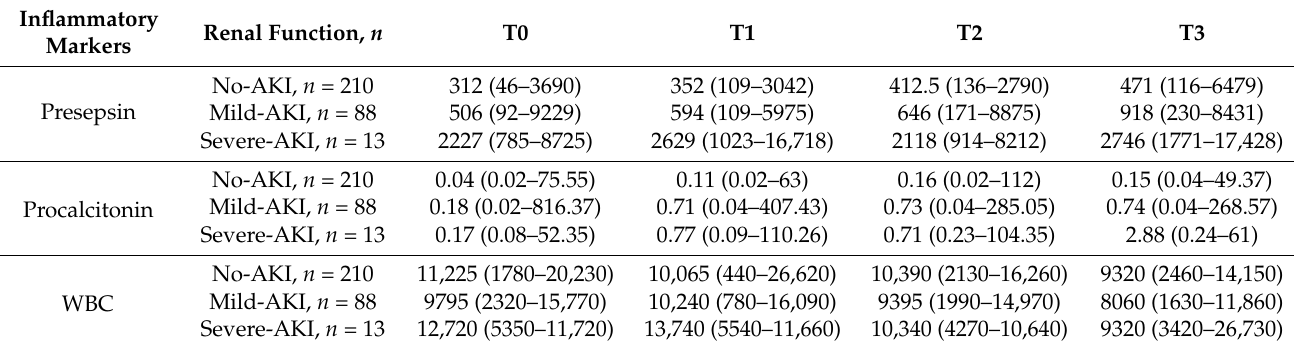
Table 5. Median values of inflammatory markers during observational period after surgery according to AKI severity: Non-AKI vs. mild-AKI (stage 1, stage 2 and stage 3 without RRT) vs. severe-AKI (stage 3 with RRT). Inflammatory